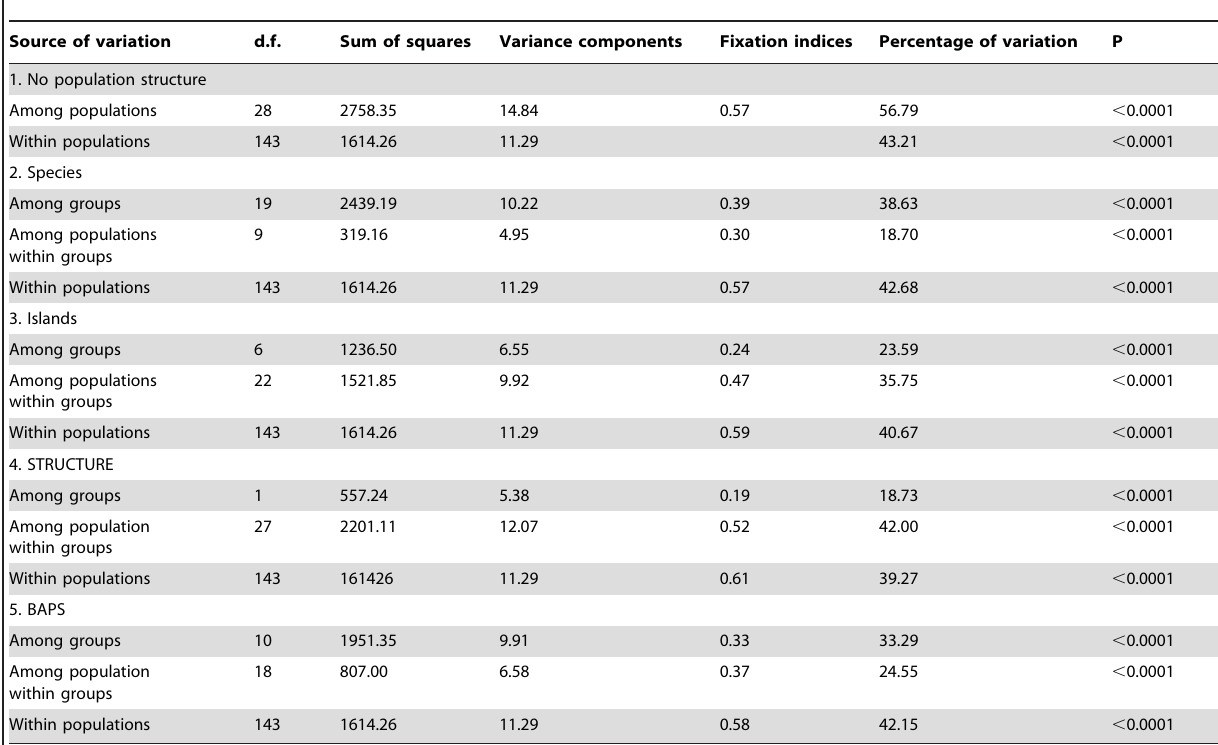
Table 1. Analyses of molecular variance (AMOVA) of Macaronesian Cheirolophus species based on AFLP markers.